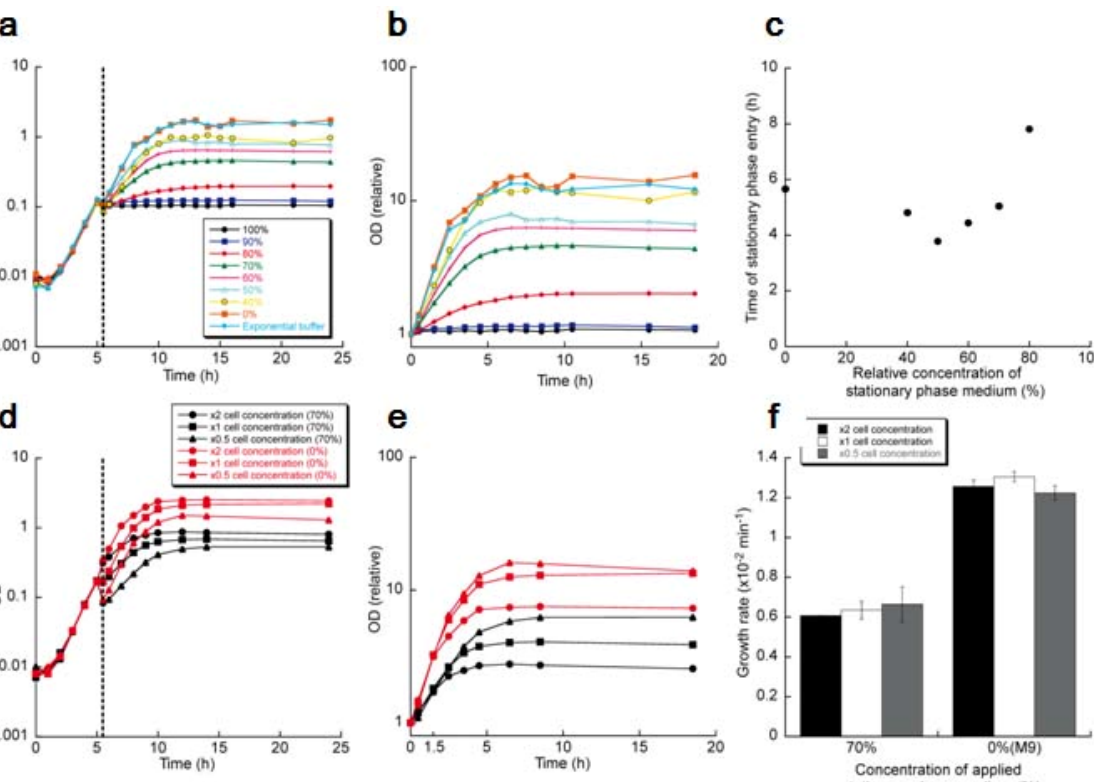
Figure 21. Response of cell populations. ( a ) Responses to stationary phase medium at various concentrations. The stationary phase media at the various concentrations were imposed on the cell populations in the mid-exponential phase; the growths in the imposed media were observed thereafter. The growth was measured by optical density at 600